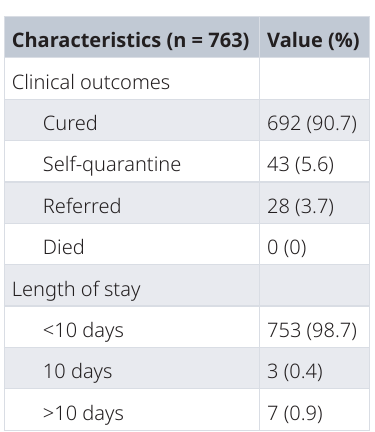
Table 4. Clinical outcomes and length of stay of patients at COVID- 19 Emergency Field Hospital of